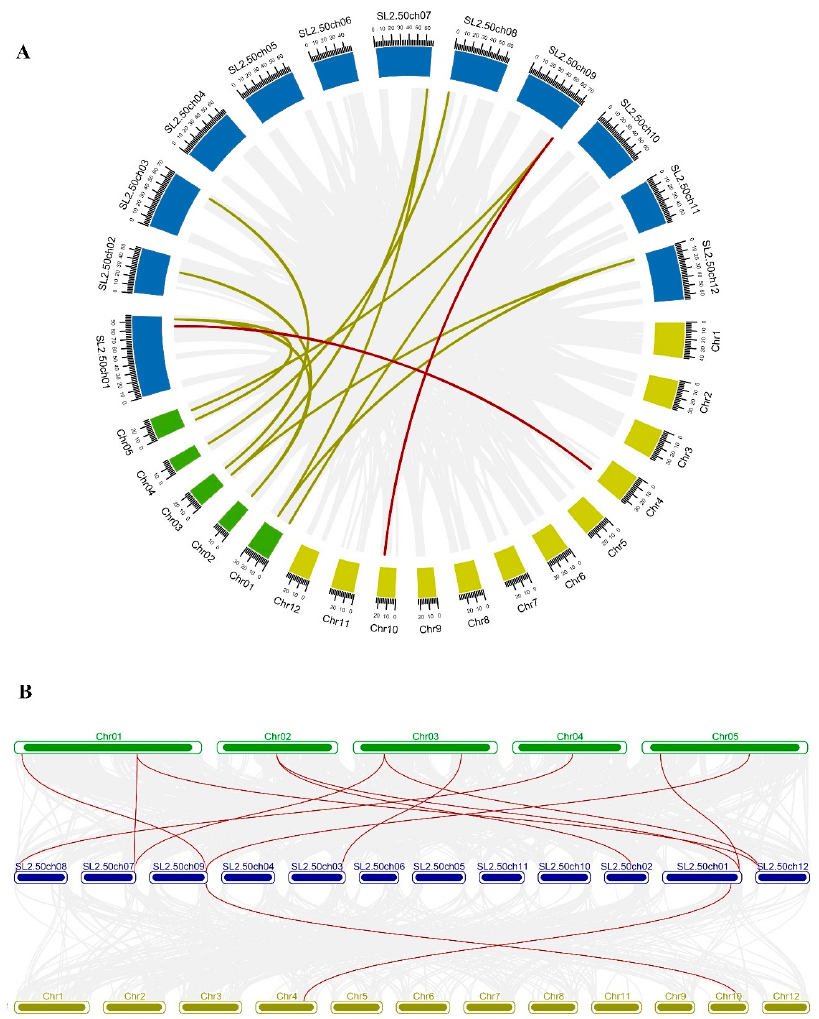
Figure 1. ( A ) Circos plot of MDH genes in the tomato, Arabidopsis , and rice genome. ( B ) Collinearity plot of SlMDH genes between Arabidopsis , and rice plant species. The chromosomes of the three species are represented in different colors: tomato, blue; Arabidopsis , green; and rice, dark yellow. All chromosomes are drawn to scale (in Mb). Gray lines in the background show collinear blocks within tomato and other plant genomes, while red lines indicate syntenic MDH gene pairs. The red lines between two chromosomal locations indicate a syntenic relationship between tomato (Sl-1 to 12) and Arabidopsis (1 to 5)/ Rice (1 to 12).